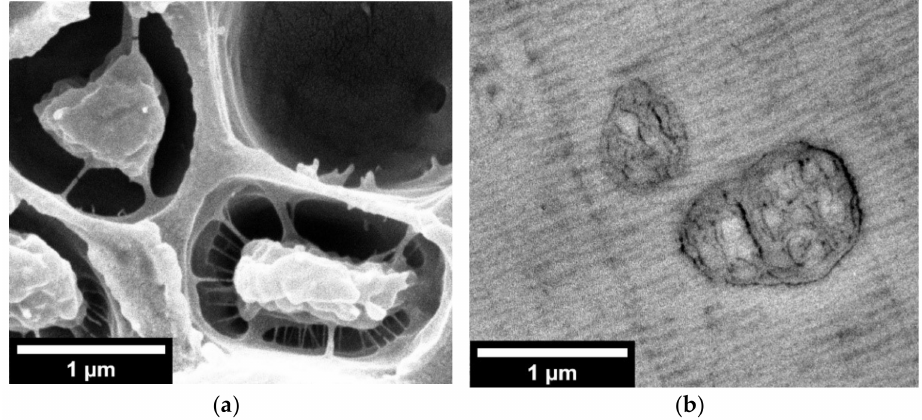
Figure 7. HRSEM micrograph of the 90/10 PMMA/MAM foams obtained from films at saturation pressure and temperature respectively of 30 MPa and 60 ◦ C ( a ); TEM micrograph of the nanostructure of the 90/10 PMMA/MAM solid films ( b